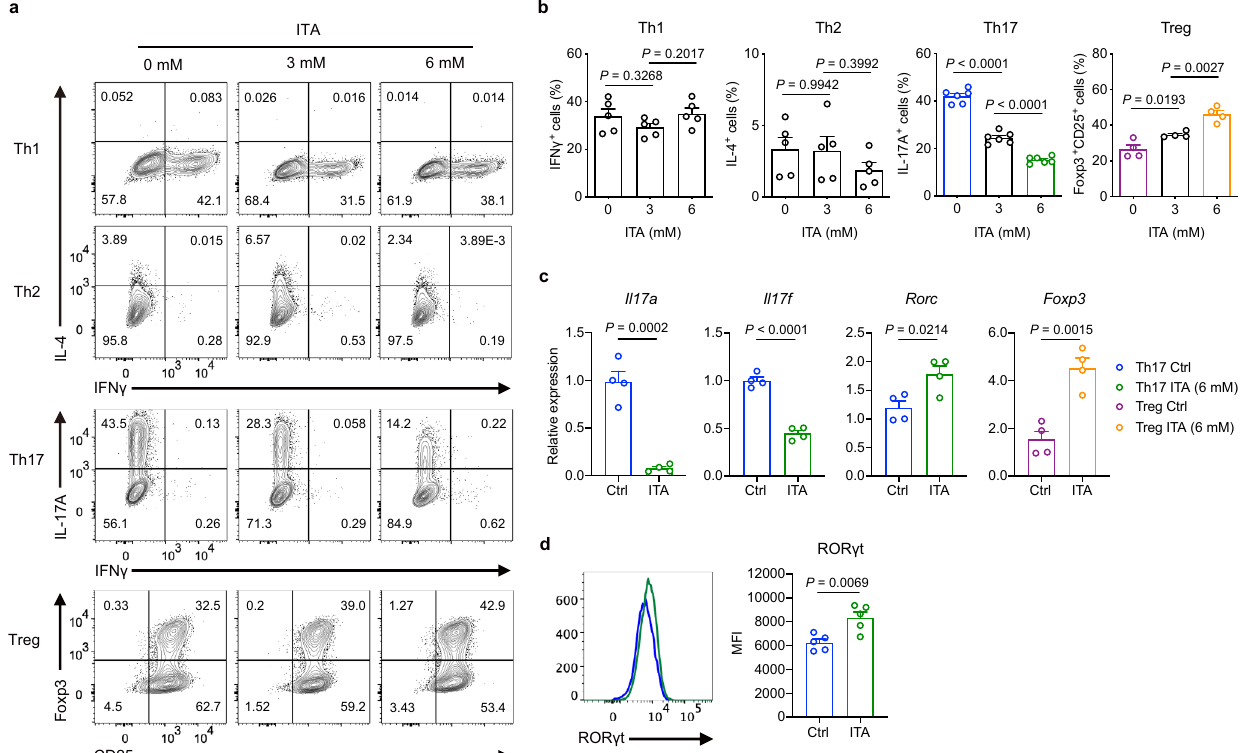
Fig. 1 | Itaconate inhibits Th17 differentiation and enhances Treg differentia- tion. Representative fl owplots( a )andcumulativedata( b )ofthedifferentiationof murine naive CD4 + T cells from wild-type B6 mice activated under Th1, Th2, Th17, and Treg cell conditions in the presence or absence of itaconate (ITA; 0, 3, and 6mM)after3daysculture(Th1andTh2, n =5;Th17, n =6;Treg, n =4). c Expression of Th17- and Treg-related genes in the presence or absence of ITA (0 and 6mM)